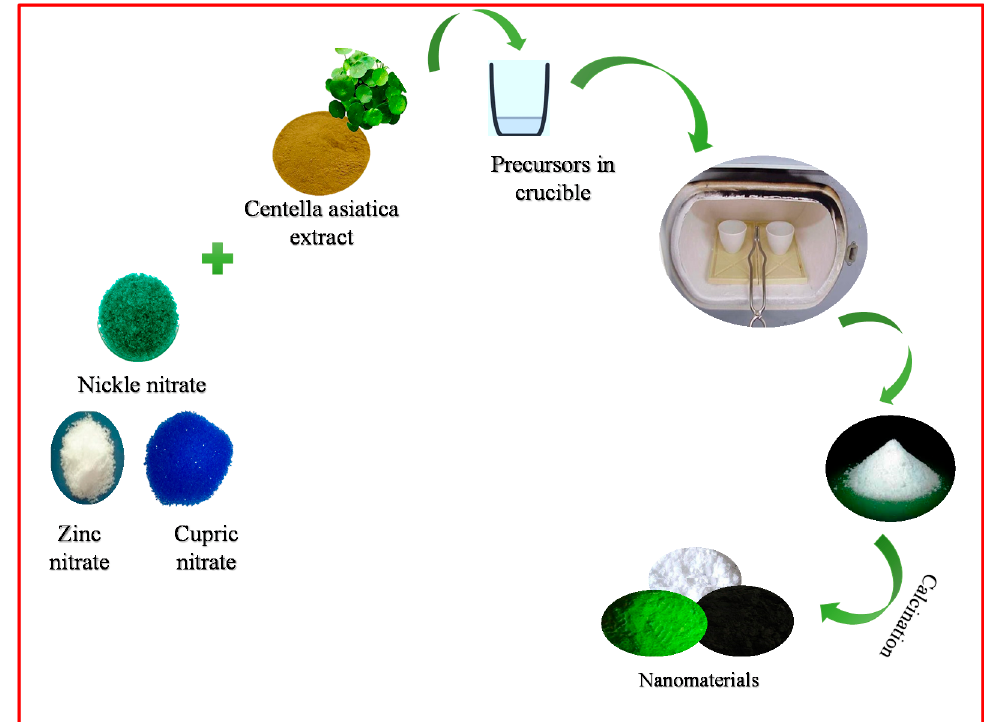
Figure 1. Schematic representation of NCZ NPs.